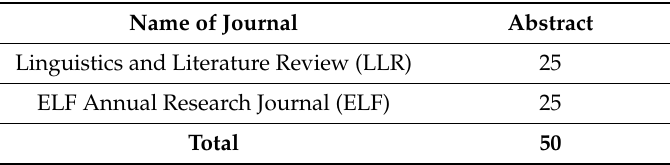
Size and distribution of Pakistani English language learners’ / experts’ / researchers’ research